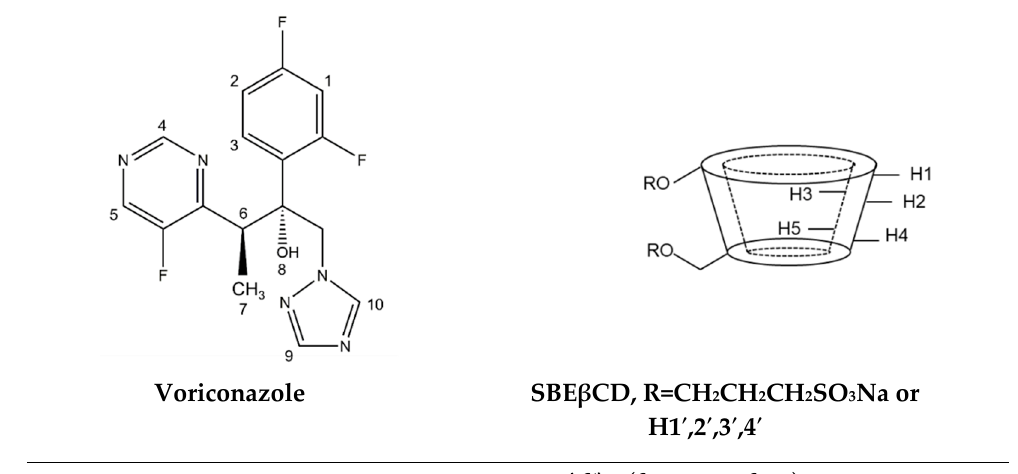
Table 4. The 1 H chemical shifts of VCZ and SBE β CD in binary VCZ/SBE β CD and ternary VCZ/SBE β CD/PVA complexes.